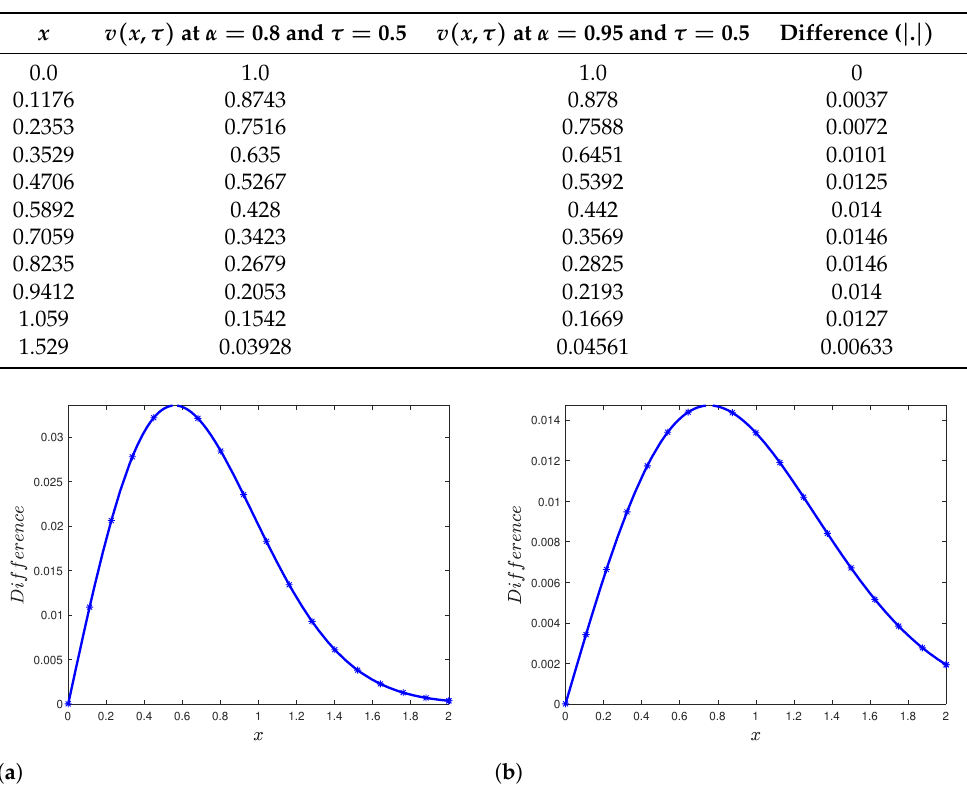
Table 2. Temperature profile with Pr = 5.